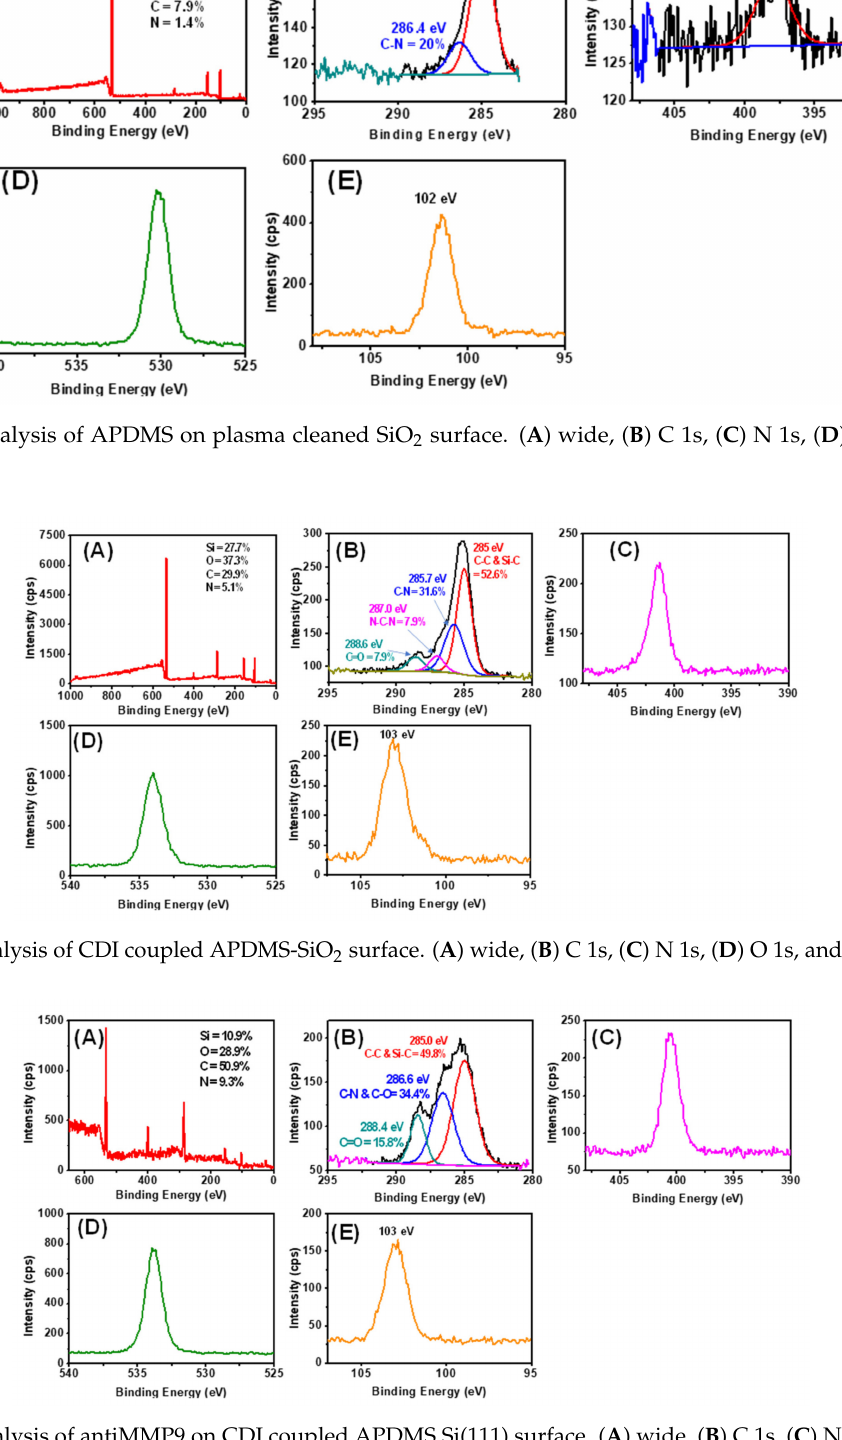
Figure A5. XPS analysis of antiMMP9 on CDI coupled APDMS Si(111) surface. ( A ) wide, ( B ) C 1s, ( C ) N 1s, ( D ) O 1s, and ( E ) Si 2p